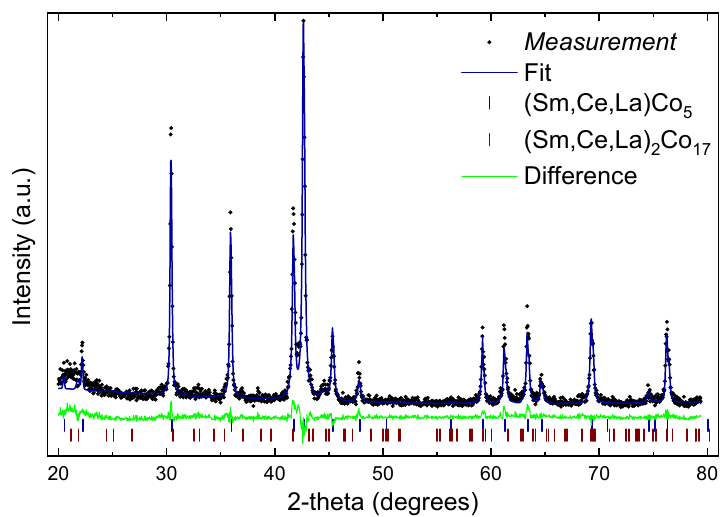
Figure 2. Rietveld analysis of Sm 1 − x (Ce 0.75 La 0.25 ) x Co 5 (x = 0.5) compound.